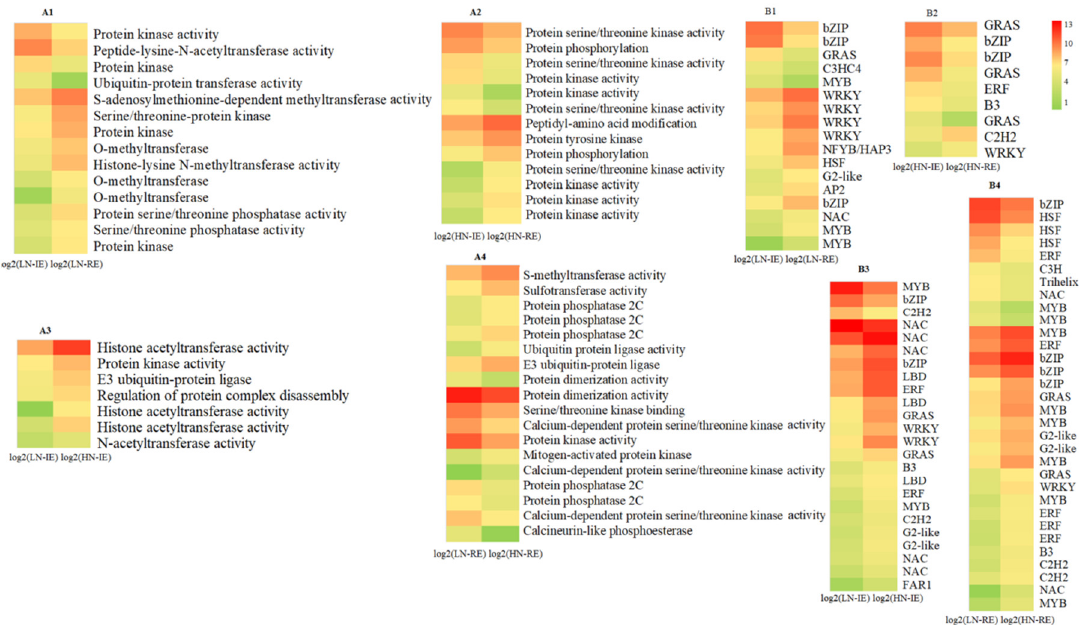
Figure 2. Heat map of differentially expressed transcription factor genes, and transcripts involved.in protein phosphorylation, methylation and ubiquitination. HN-IE and HN-RE are samples from innermost endosperm region and the remaining endosperm region under high nitrogen treatment, respectively. LN-IE and LN-RE are samples from innermost endosperm region and the remaining endosperm region under low nitrogen treatment, respectively. A1 , A2 , A3 and A4 indicate the genes involved in protein post-translation modification. B1 , B2 , B3 and B4 indicate the transcription factor genes. Red color represent high expression level and green represent low expression level.